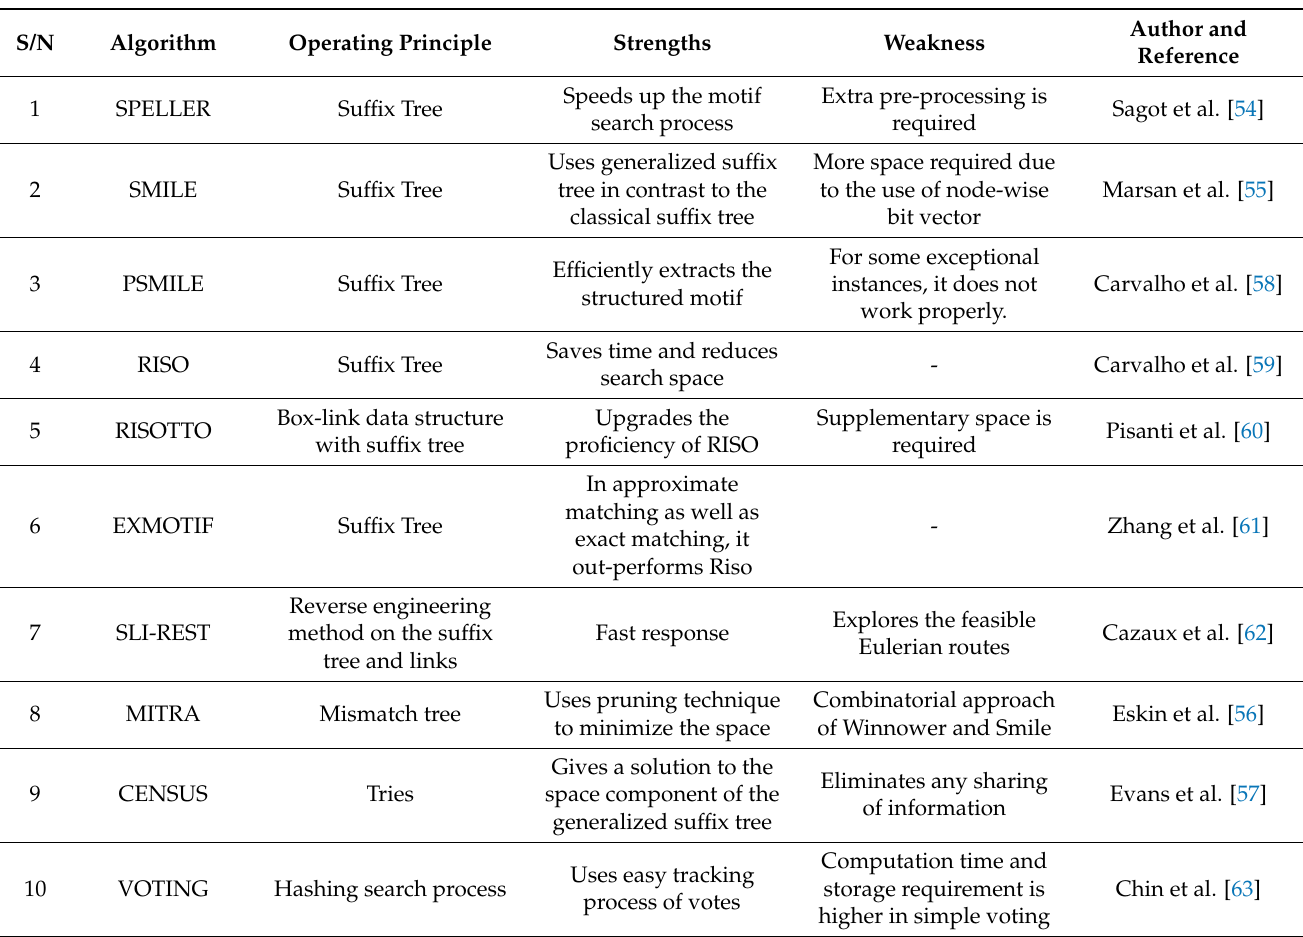
Table A6. List of Exact Motif Discovery Algorithms based on Suffix tree, Mismatch tree, Tries, and Hashing Search